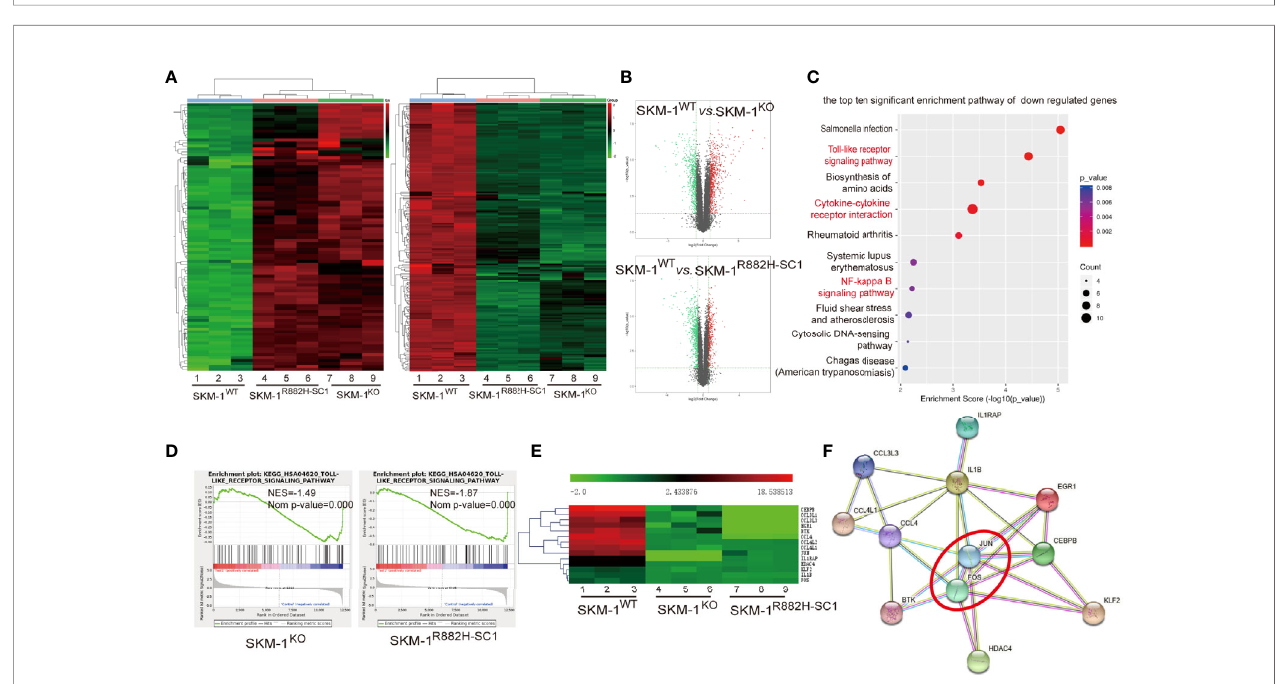
FIGURE 2 | The difference in gene expression between SKM-1 R882H , SKM-1 KO and SKM-1 WT cells. (A) Cluster analysis of differential genes, red means upregulated expression, green means downregulated expression. (B) The volcanic map analysis of differentially expressed genes (fold change ≥ 2 and p-Value ≤ 0.05), the red indicates the signi fi cantly upregulated gene, the green indicates the signi fi cant downregulated. (C) KEGG pathway enrichment analysis. The size of the circle indicates the number of differential genes, and the warm and cold color indicates the size of the P-value. The ordinate indicates the enrichment pathway, and the abscissa indicates the enrichment score. In fl ammation- and immune-related pathways was marked in red. (D) GSEA indicates that the TLR pathway was downregulated in knockout (KO) and R882H cells. (E) Cluster analysis of the differential genes. (F) Interaction networks functional enrichment analysis of differential proteins. Red circles indicate key regulatory